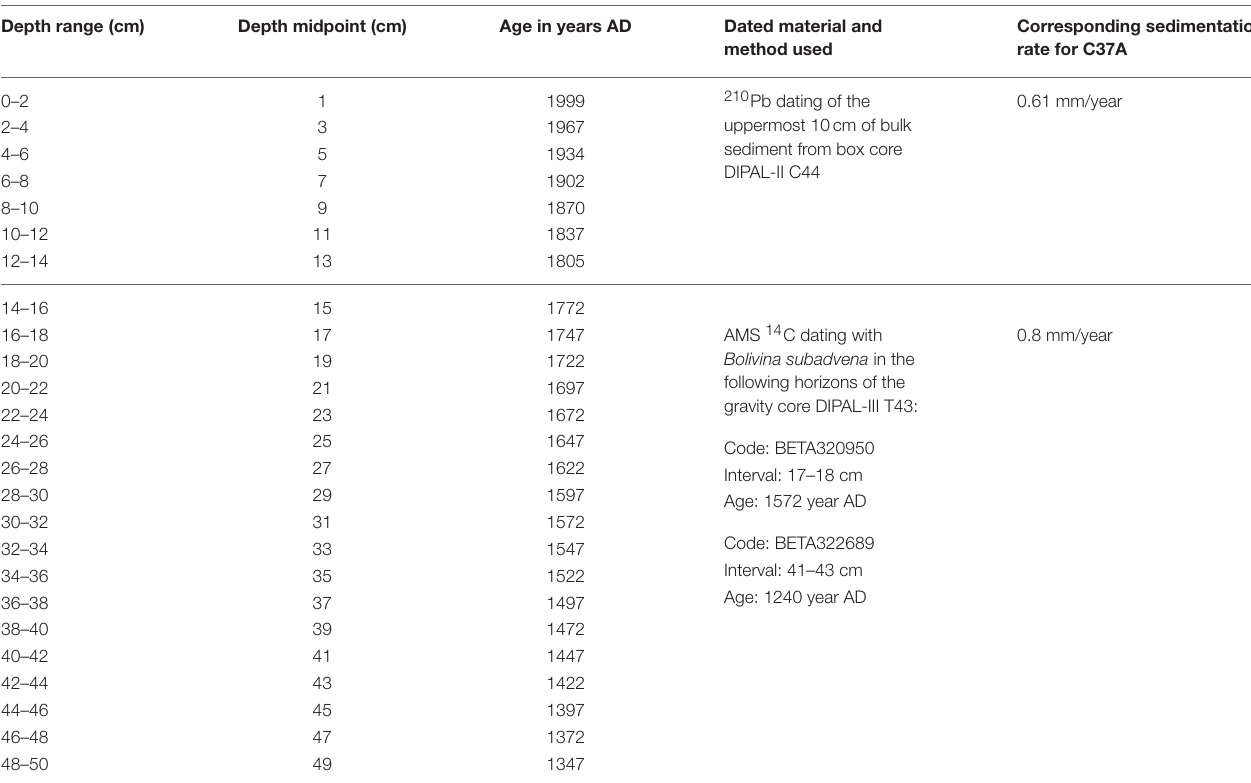
TABLE 1 | Age model for core C37A, constructed by a combination of extrapolated average sedimentation rates produced using the 210 Pb method on core DIPAL-II C44 (Choumiline et al., 2010; Choumiline, 2011) and acceleration mass spectrometry 14 C on core DIPAL-III T43 (Pérez-Cruz, 2013). Depth range